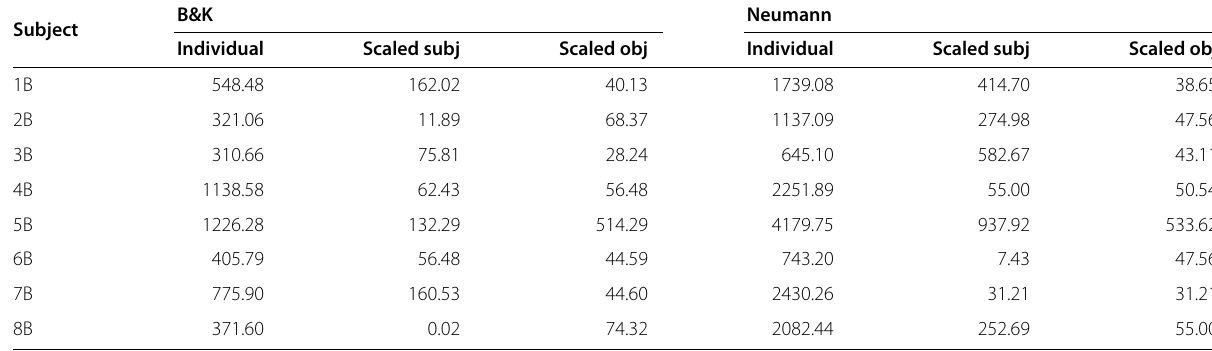
Table 7 MSE of the adapted ITD from the validation measurements. [ μ s 2